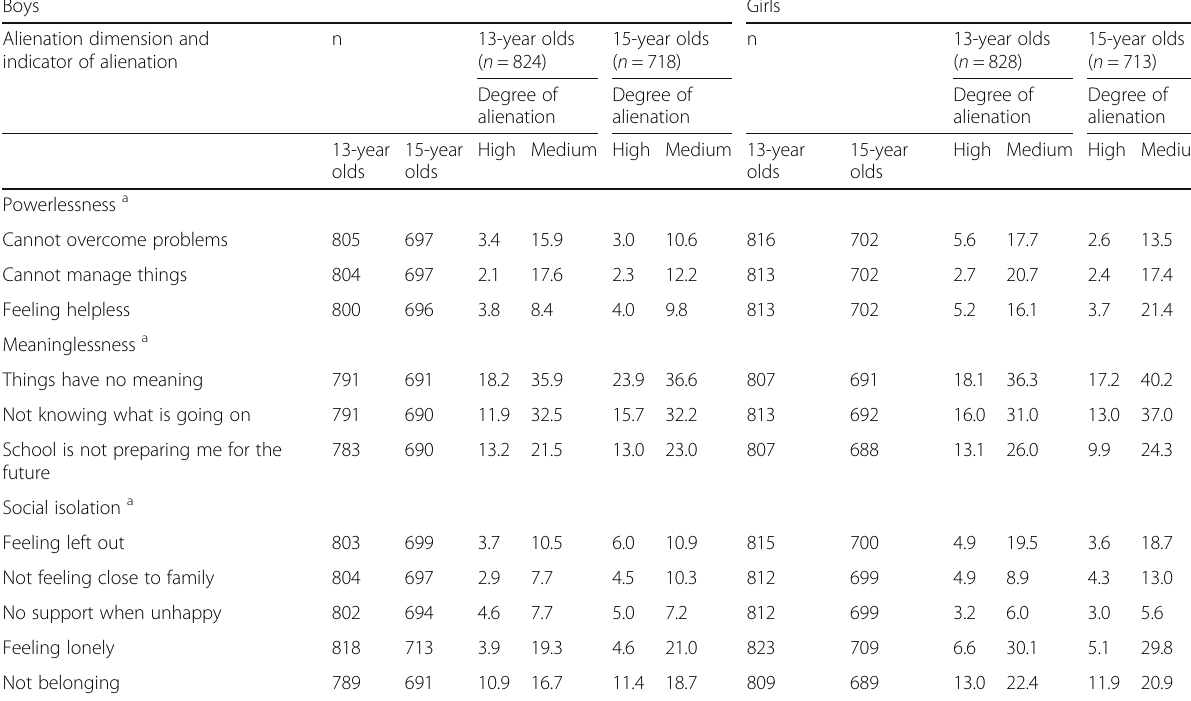
Table 2 Percentage with high or medium indication of alienation item by item stratified by sex and age